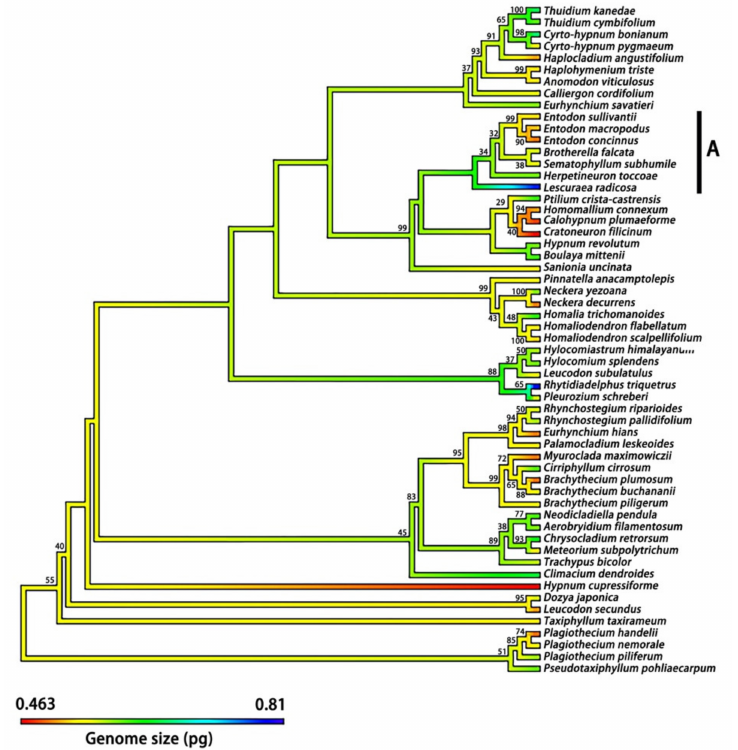
Figure 7. Continuous character state mapping of the average DNA 1C values (genome sizes), ranging from 0.463 pg (red) to 0.810 pg (blue), onto a ultrametric tree that includes 57 species of the order Hypnales by using the ContMap function with default settings from the phytools package in R. Clade A indicated a strong phylogenetic signal of DNA 1C value across the seven species. The maximum likelihood bootstrap values are labelled above the